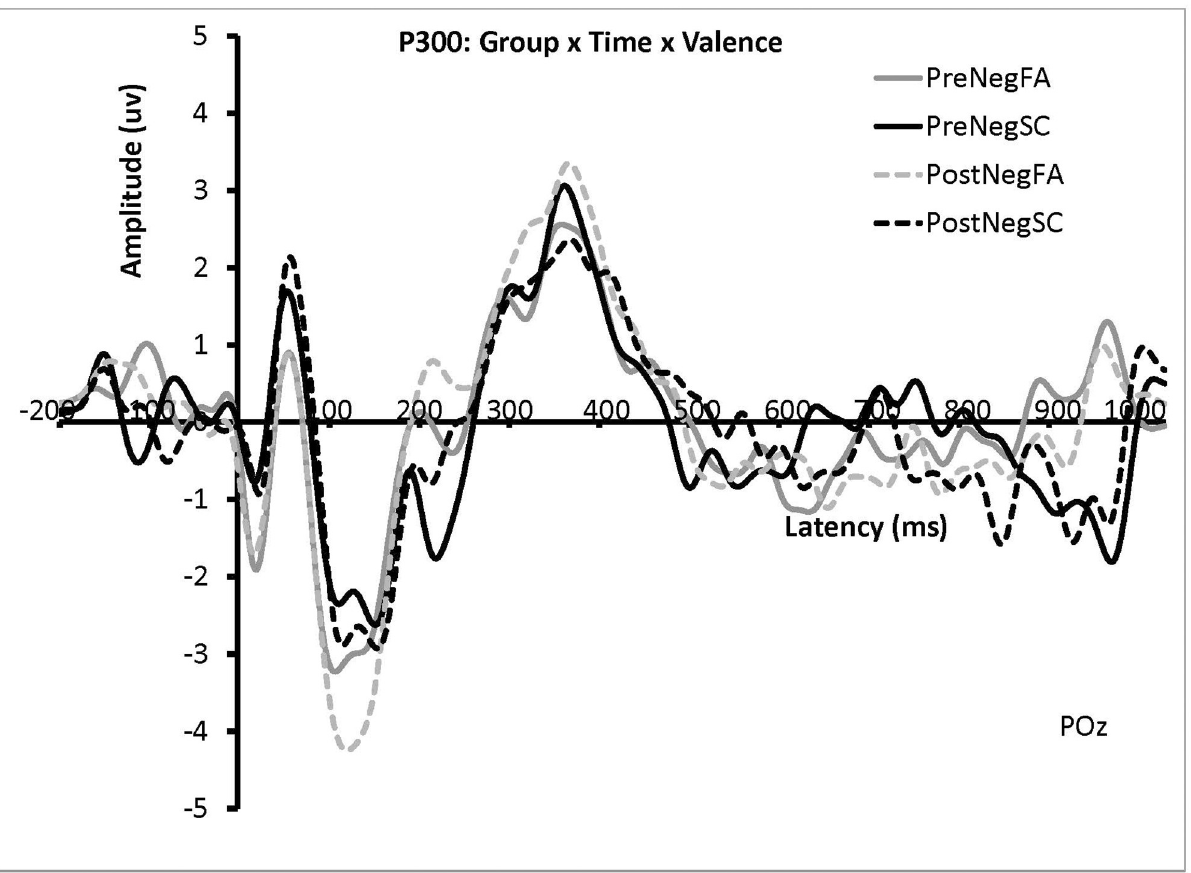
Fig 4. Grand average waveforms showing the effect of group and time on negative prime trials on P3 amplitude at channel POz. The solid lines indicate the grand average waveforms for the negative-valence Flanker trials pre-training. The dashed lines indicate the grand average waveforms for the negative-valence Flanker trials